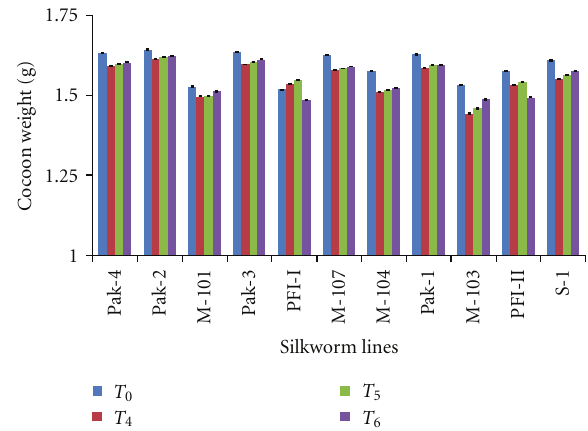
Figure 2: Comparative performance of cocoon weight (mean ± SE) eleven silkworm lines at 30 ± 1 ◦ C in combination with 55, 65, and 75% RH and controlled conditions of temperature and RH (25 ± 1 ◦ C and 70–80%,